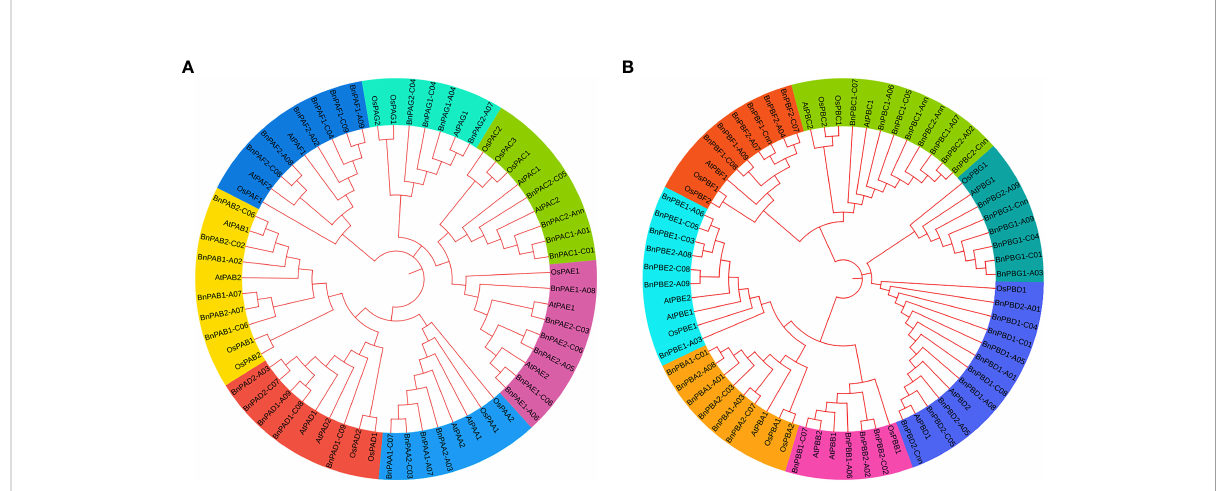
FIGURE 8 Phylogenetic tree constructed using protein sequences of (A) a -subunits and (B) b -subunits belonging to three plant species ( A. thaliana , O. sativa and B. napus ). Seven different colors in the tree represent seven different